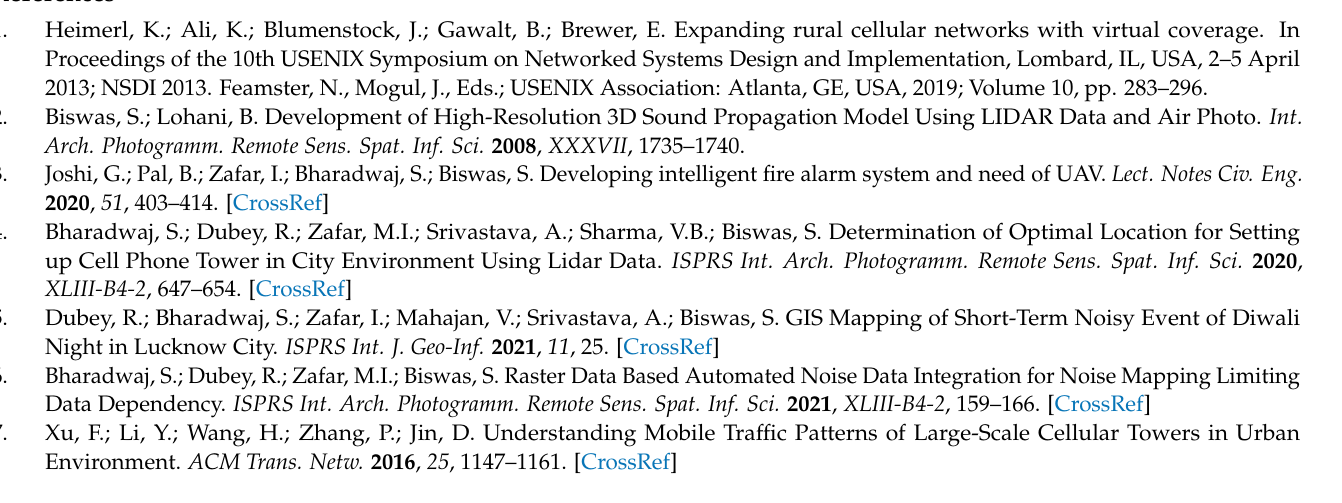
choosing the dimension of buffer near the centroid region; Figure S10: Signal strength for the L-shape to choose the best location with a chosen buffer region; Figure S11: ( a ) Another L-shaped case is taken to approximate the dimension of buffer, ( b ) U-shaped case for buffer dimension approximation; Figure S12: Signal strength map for one proposed cell phone tower on campus; Figure S13: ( a ) Signal strength 3D map for the RGIPT campus from Jio tower placed outside campus, ( b ) Signal strength 3D map for the RGIPT campus from one proposed Jio tower inside campus; Figure S14: Combinations of angle area division into three equal parts; Figure S15: ( a ) Three equal areas (Area 1, Area 2, and Area 3) of the chosen combination of angle division, ( b ) Area 1 of RGIPT is inscribed in a rectangle; Figure S16: Buffer region selection for correction of the centroid of Area 1; Figure S17: Signal strength map for Areas 2 and 3; Figure S18: ( a ) Signal strength map for three proposed cell phone towers on campus, ( b ) Signal strength map for two proposed cell phone towers on campus; Figure S19: ( a ) Shahganj area of Agra city (Urban area) chosen for the determination of the best location of cell phone tower, ( b ) Shahganj area LIDAR generated data, ( c ) Digital Elevation Model for the Shahganj area of Agra city; Figure S20: ( a ) Previously installed cell phone tower location. ( b ) Signal strength due to the five cell phone towers; Figure S21: ( a ) Five proposed cell phone tower locations. ( b ) Signal strength due to these five proposed cell phone towers; Figure S22: ( a ) Four proposed cell phone tower locations. ( b ) Signal strength due to these five proposed cell phone towers; Figure S23: ( a ) Three-dimensional signal strength map for the Shahganj area due to previously installed cell phone tower locations, ( b ) 3D signal strength map for the Shahganj area due to proposed cell phone tower locations; Figure S24: ( a ) Effect of previously installed cell phone towers on building walls and corners, ( b ) Effect of proposed cell phone towers on building walls and corners; Figure S25: ( a ) Optimization map for previously installed cell phone towers. ( b ) Optimization map for proposed cell phone